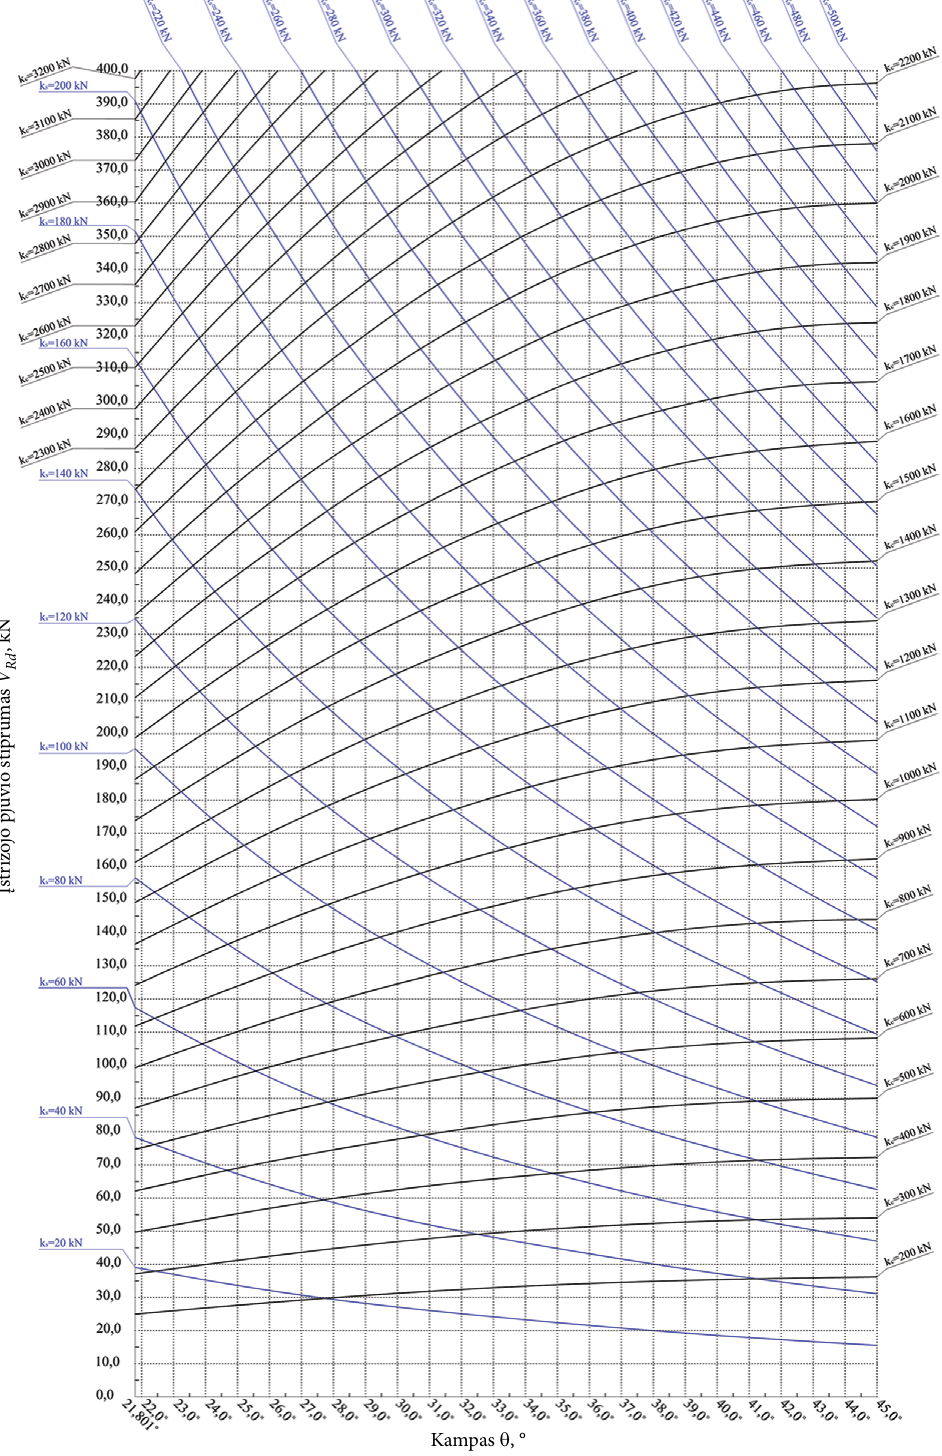
Fig. 9. The 1st graphic of shear strength identification of bending elements with vertical shear